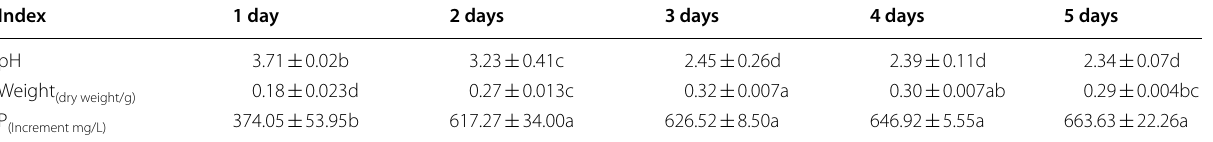
Values are mean SD (n 3). Means sharing a common letter within the same column are not significantly different at P < 0.05 ± =